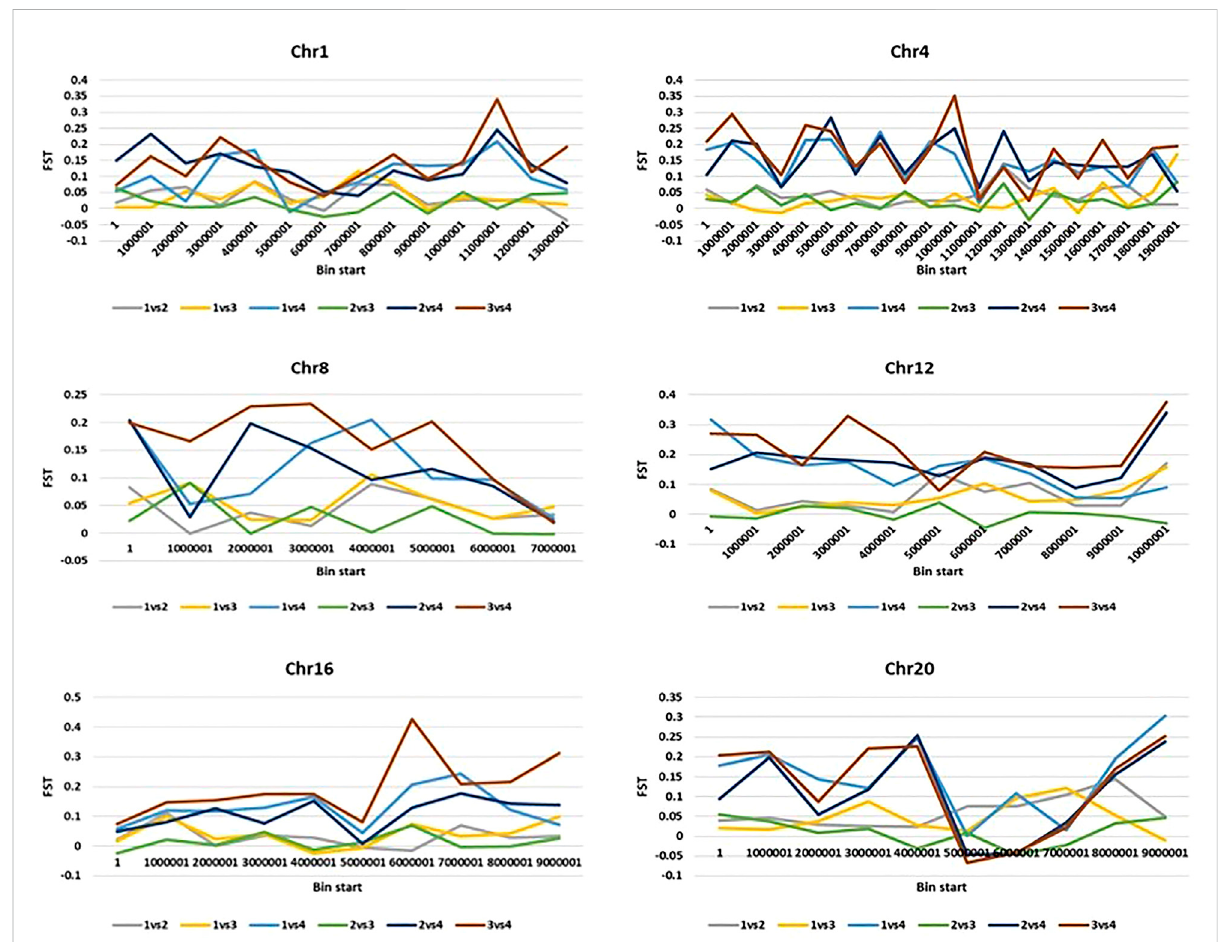
FIGURE 3 2-kbslidingwindowsofchromosomes1,4,8,12,16and20depictingpairwise F ST sofvariousgroups(I:Australian,II:Buttercup,Zapallito,Turban, III: Hubbard and Banana and IV: